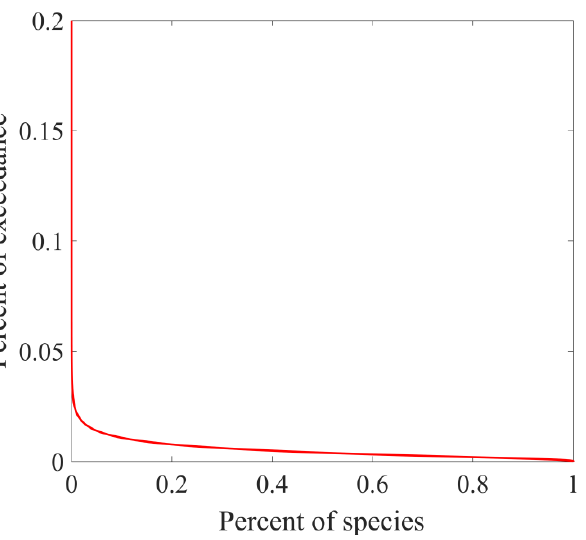
Figure 6. Joint probability curve for ecological risk of carbamazepine in the Nansi Lake basin.